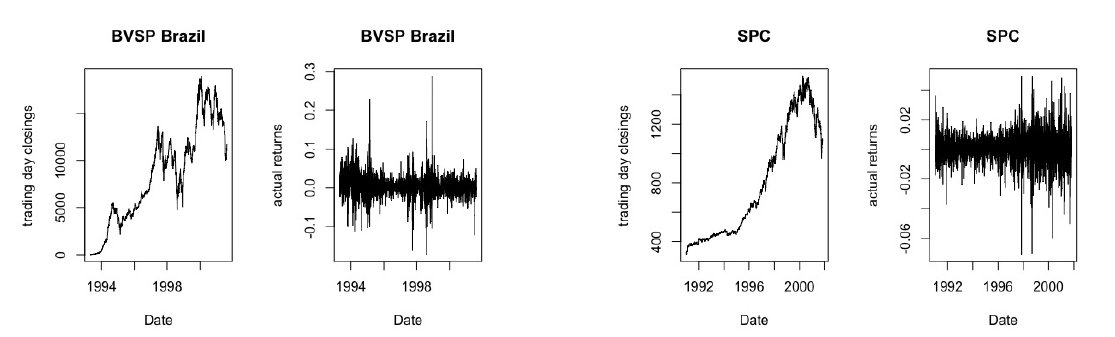
Figure 2. Plots of trading days closings and actual returns of BVSP and SPC.